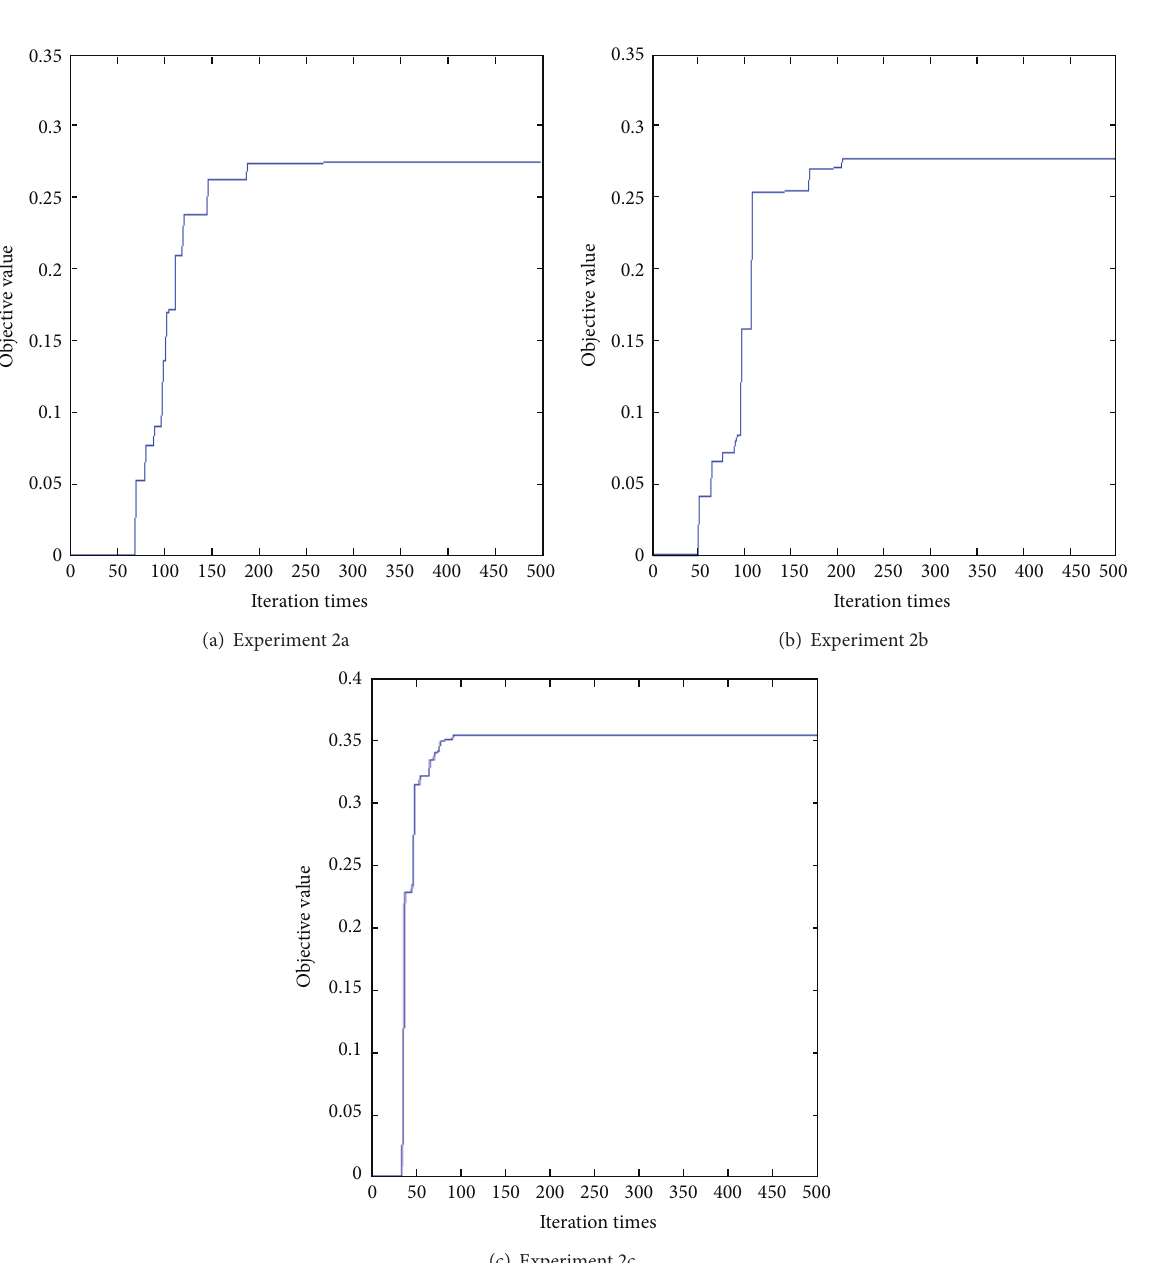
Figure 6: Convergent curve of IDE for Experiment